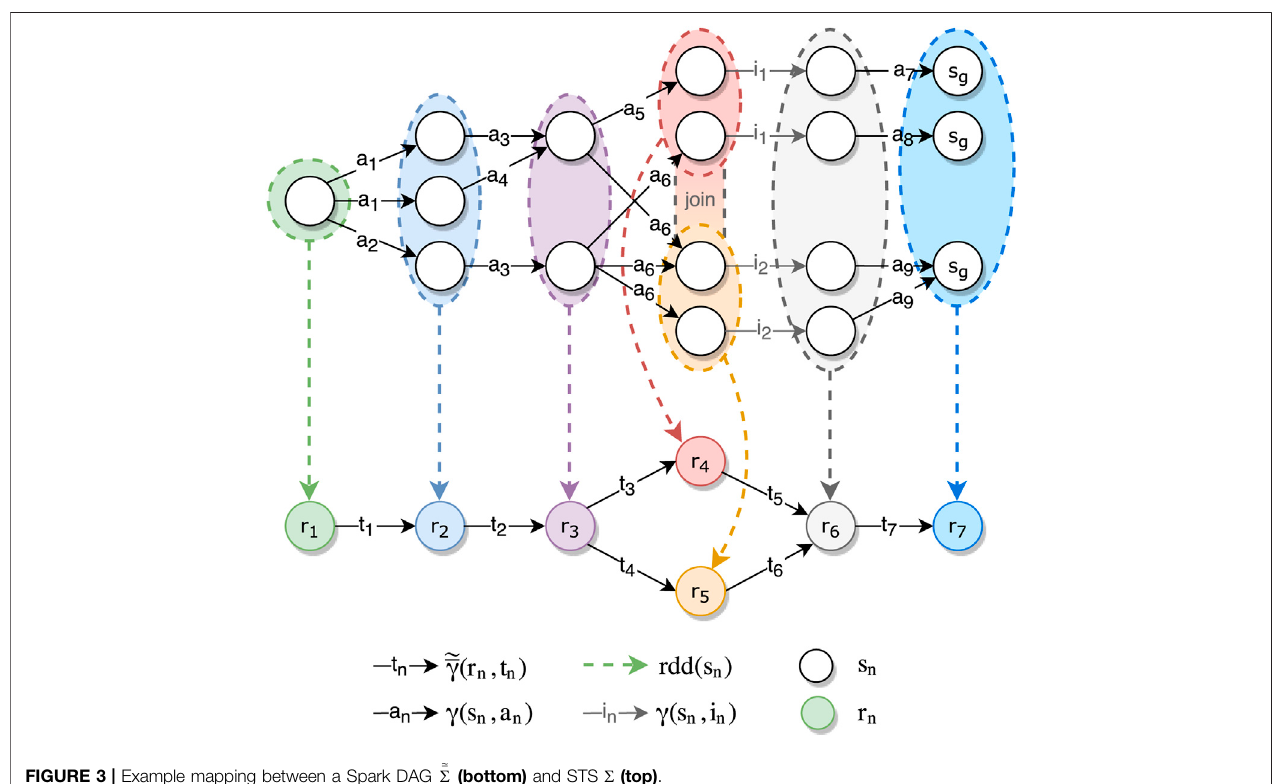
FIGURE 3 | Example mapping between a Spark DAG Σ